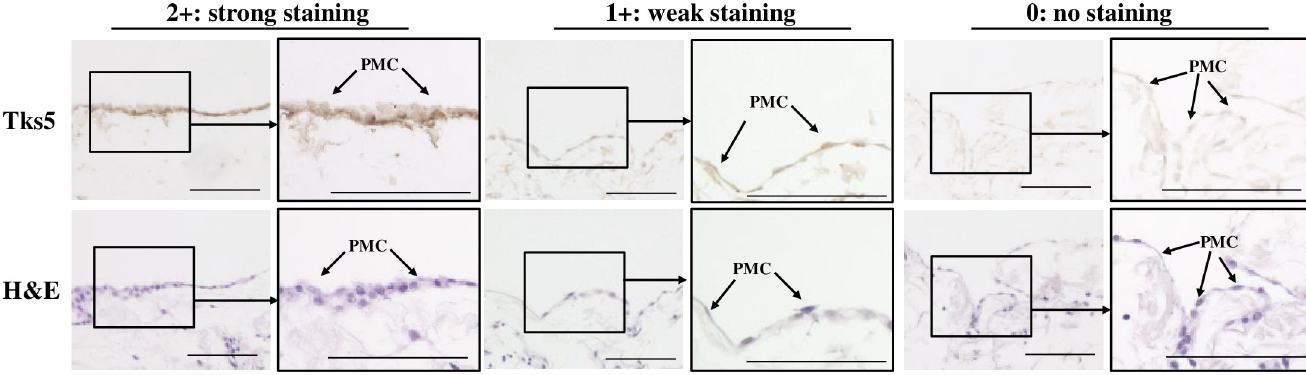
Fig 1. Representative images of peritoneal mesothelial cells of patients with gastric cancer. Tks5 expression was found in the cytoplasm of the PMCs forming a monolayer on the greater omentum, lesser omentum, or retroperitoneum in a GC patient. Intensity score: 0; no staining, 1+; weak staining, 2+; strong staining. Positive staining was defined as 1+ or 2+. Arrow, PMC: peritoneal mesothelial